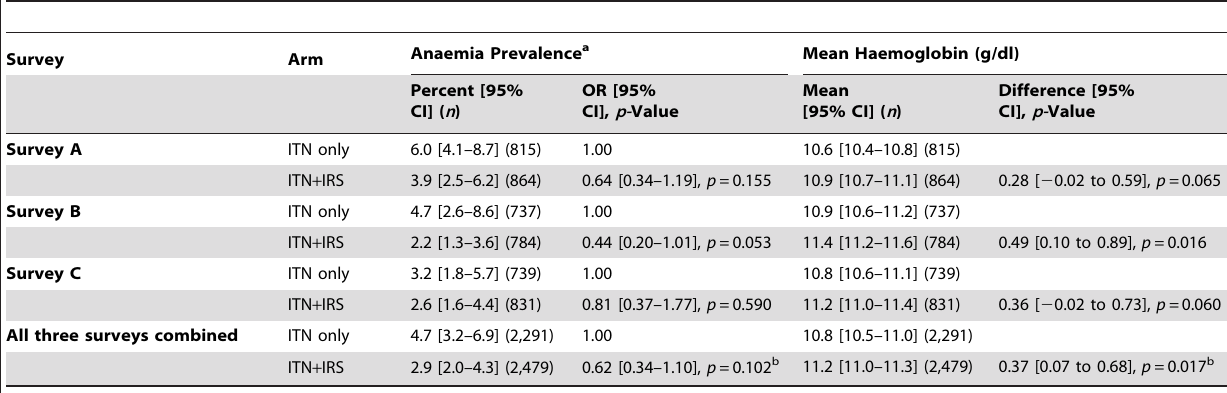
Table 5. Anaemia and mean haemoglobin in children under 5 y old in the ITN only and ITN + IRS arms (intention to treat), for survey A, B, and C, Muleba District, Tanzania, 2012.